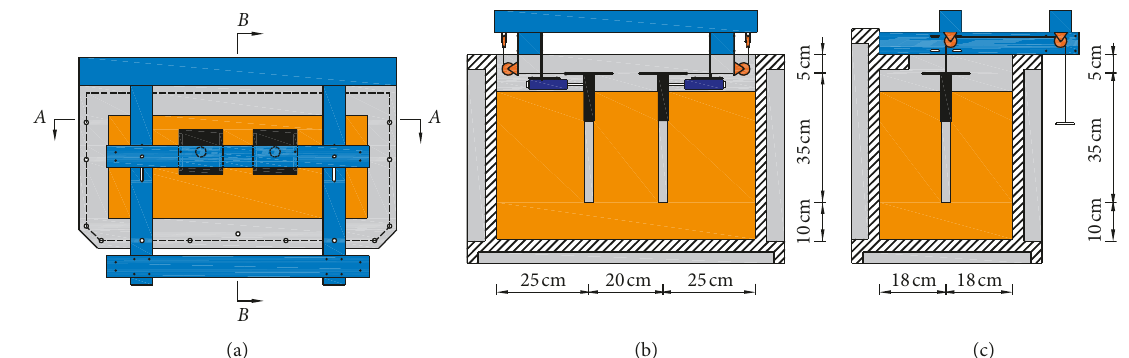
Figure 8: The position of the model piles: (a) Planar graph; (b) A-A section diagram; (c) B-B section diagram.